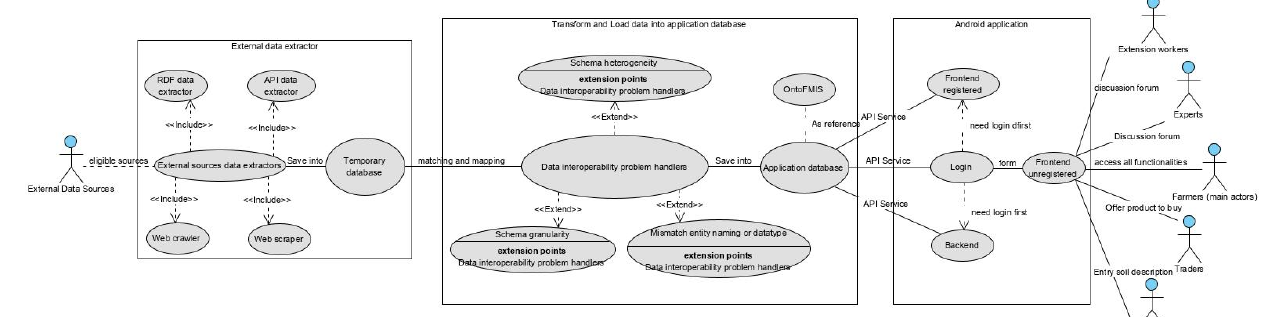
Figure 3. A rich picture in UML diagram format of the small Farm Management Information System (sFMIS).